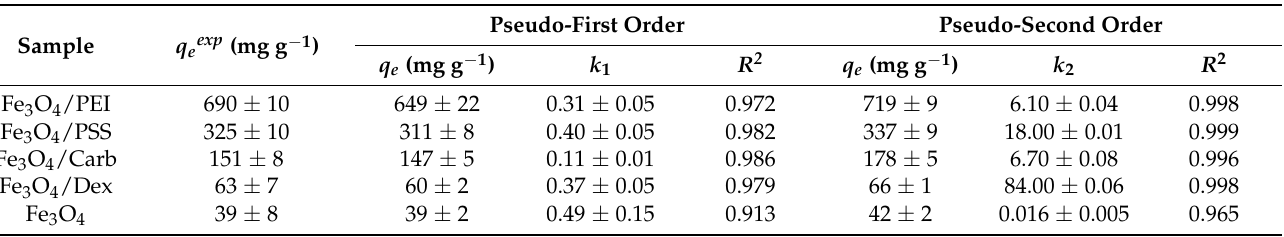
Figure 6. Adsorption kinetic curves of DOX onto different magnetite nanoparticles. Table 5. Kinetic parameters of the pseudo-first- and pseudo-second-order for the sorption of DOX at 25 °C.